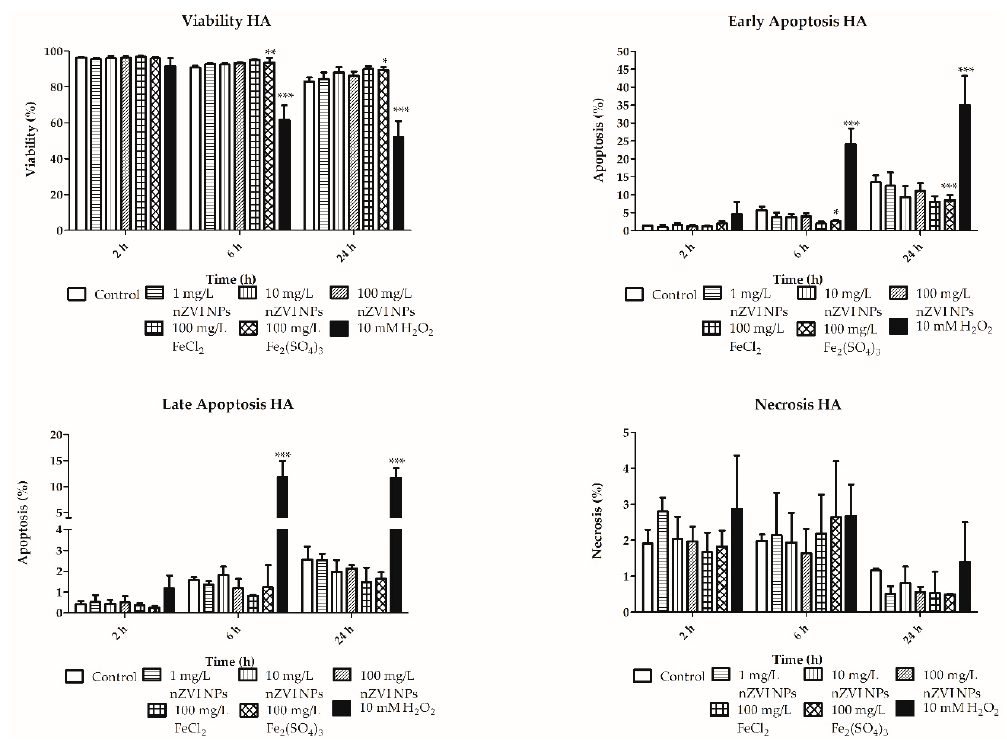
Figure 4. Viability, early and late apoptosis, and necrosis of granular amoebocytes (GA) after exposure to nZVI NPs, FeCl 2 and Fe 2 (SO 4 ) 3 for 2, 6 and 24 h; 10 mM H 2 O 2 was used as a positive control; * p < 0.05, ** p < 0.01, *** p < 0.001.